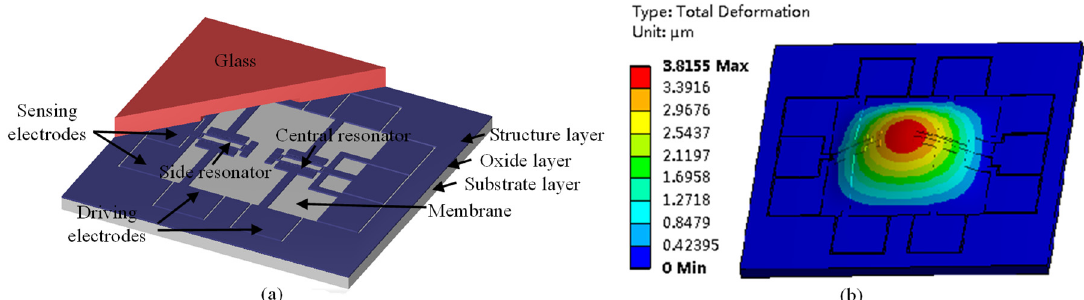
Figure 1. ( a ) Schematic of the microfabricated resonant pressure sensor in which a pair of double-ended tuning forks were utilized as resonators where comb electrodes were used for electrostatic excitation and single crystal silicon based resistors were used for piezoresistive detection. ( b ) Pressure under measurements causes the deformation of the pressure-sensitive diaphragm, leading to frequency shift of the resonators.